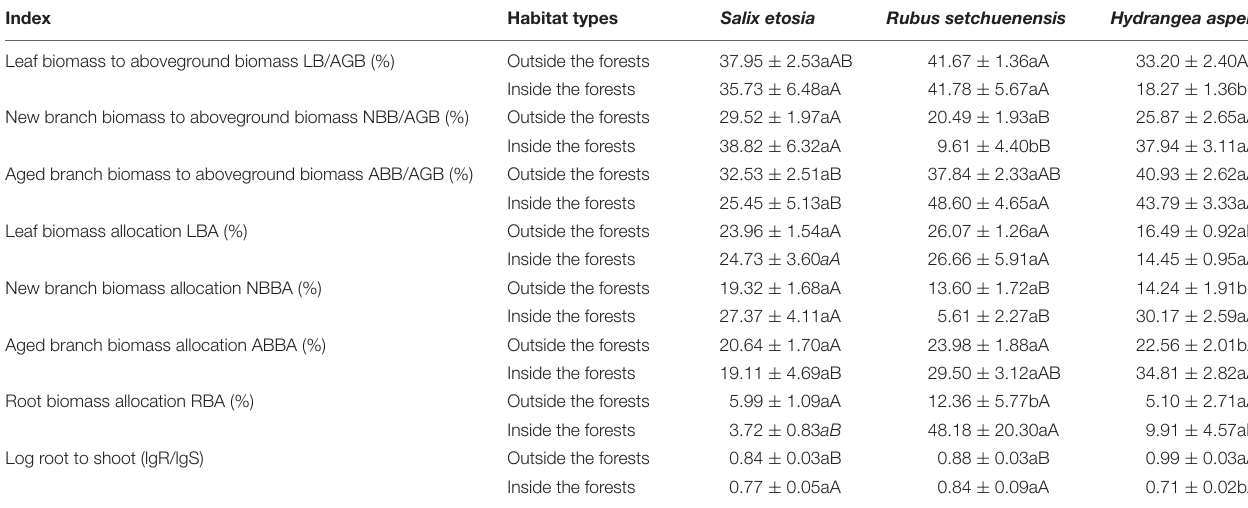
TABLE 3 | Biomass allocation of different organs of three shrubs under two heterogeneous